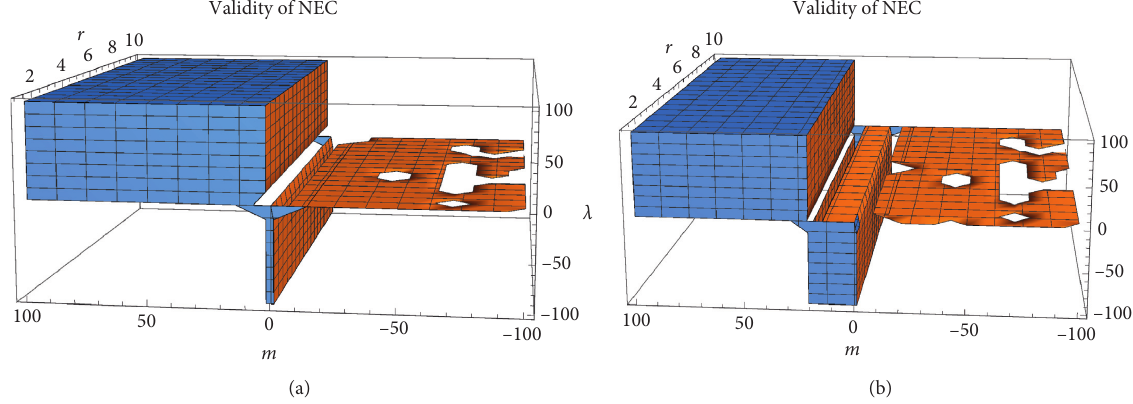
Figure 2: For α > 0 , c > 0. The left plot shows the feasible regions of NEC-1 ( ρ + p right plot, viability regions of NEC-1 ( ρ + p r ≥ 0 ) for β < 0 are presented.